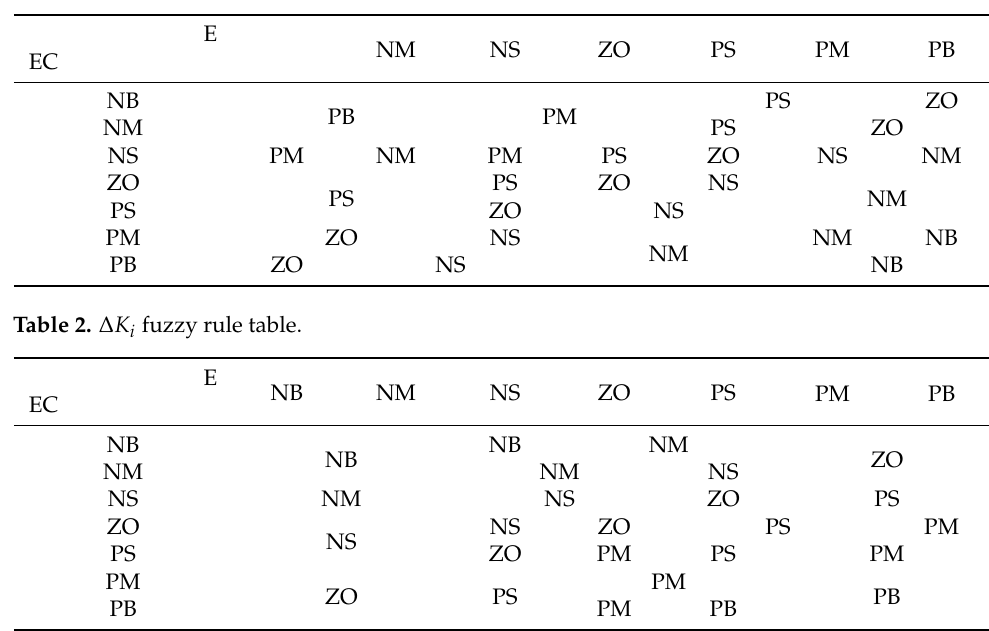
Table 1. ∆ K p fuzzy rule table.